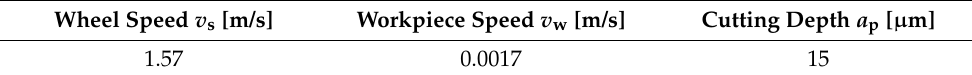
Table 2. Grinding parameters on DMG 635 V.